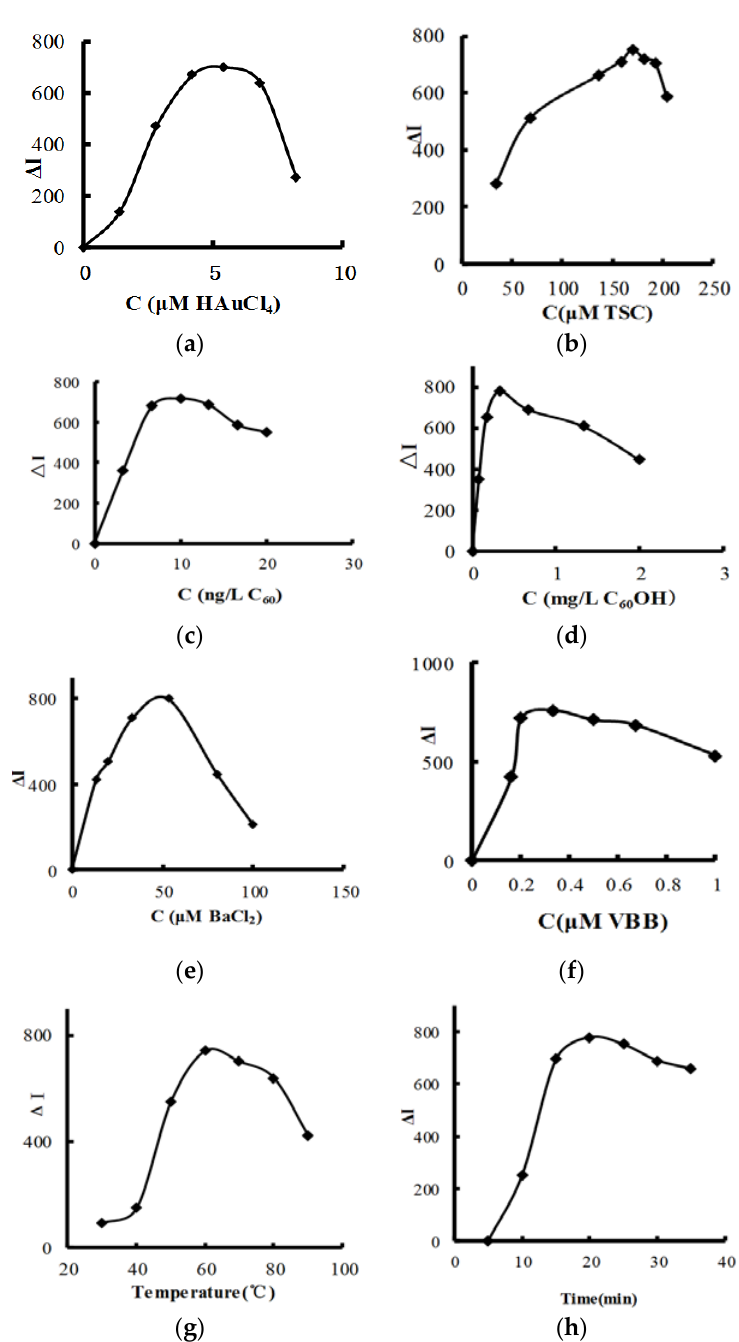
Figure 4. Effect of reagent concentration, reaction temperature and time: ( a ) HAuCl 4 + 0.33 μM VBB +